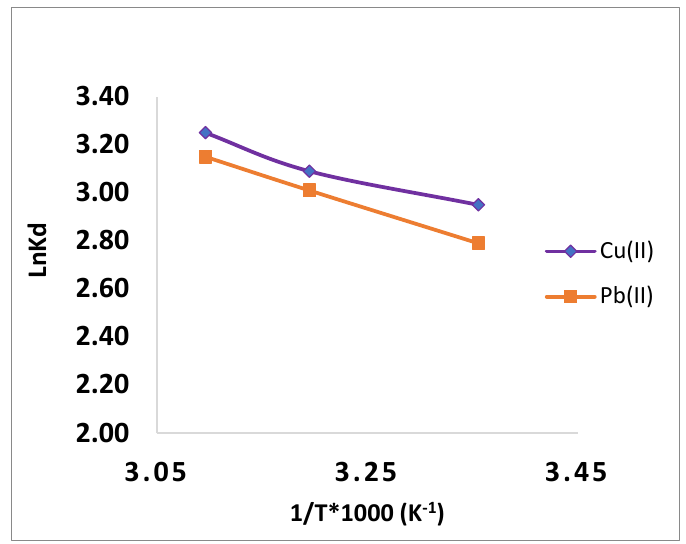
Figure 10. Adsorption thermodynamics of Pb(II) and Cu(II) ions onto CMOISW.